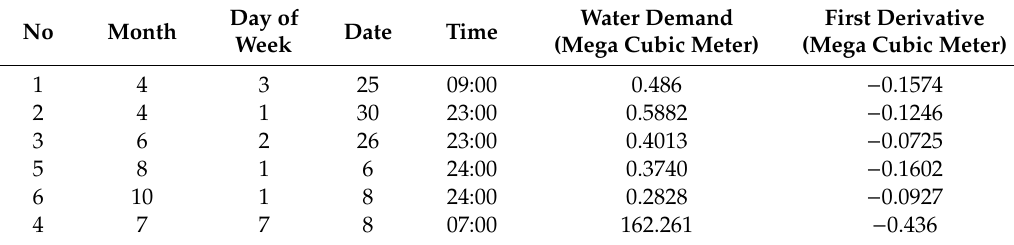
Figure 12. Normalized weekend series with detected anomalies (April–September). Table 3. Parameters of missed detected